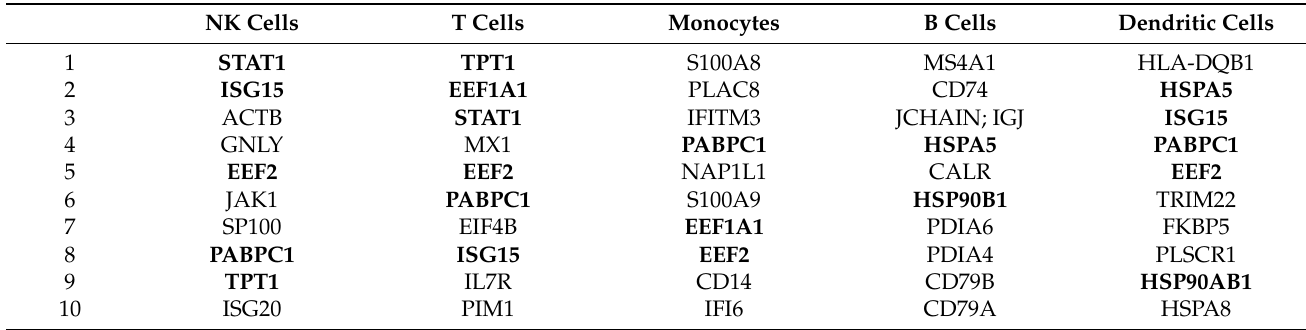
Figure 2. Overlap in genes affected by chemical exposures and SARS-CoV-2 infection in different types of human immune cells. Table 2. Top ten genes sensitive to COVID-19 and chemical exposures in immune cells. Genes sensitive to both xenobiotics and SARS-CoV-2 in more than one cell type are shown in bold.